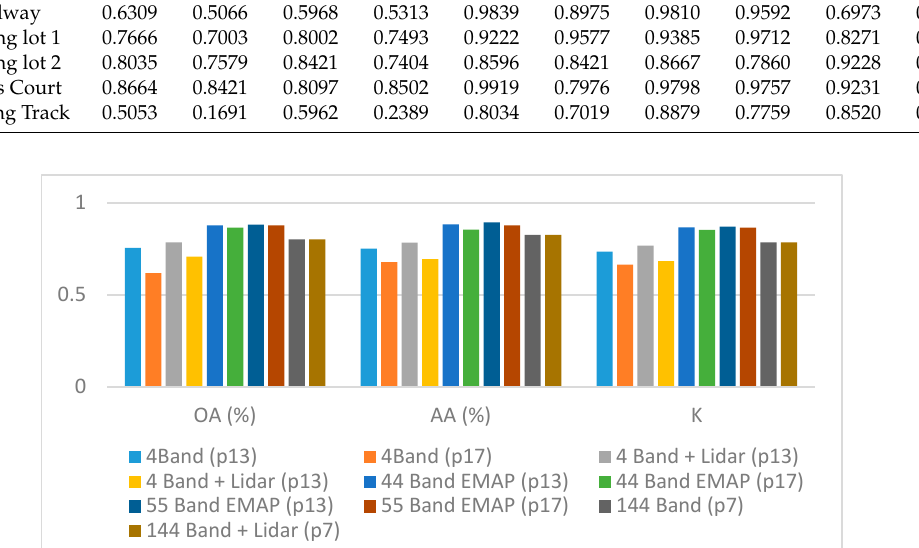
Figure 7. Performance metrics for the investigated band combinations with the CNN-3D model.